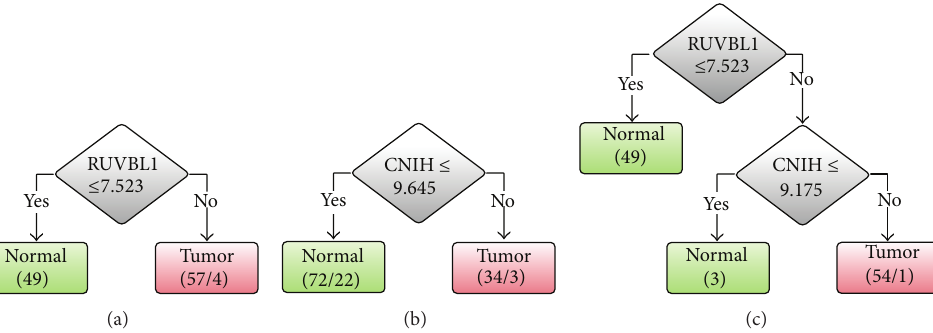
Figure 2: Decision tree classifiers based on GSE23400 dataset using (a) RUVBL1, (b) CNIH, and (c) both RUVBL1 and CNIH.